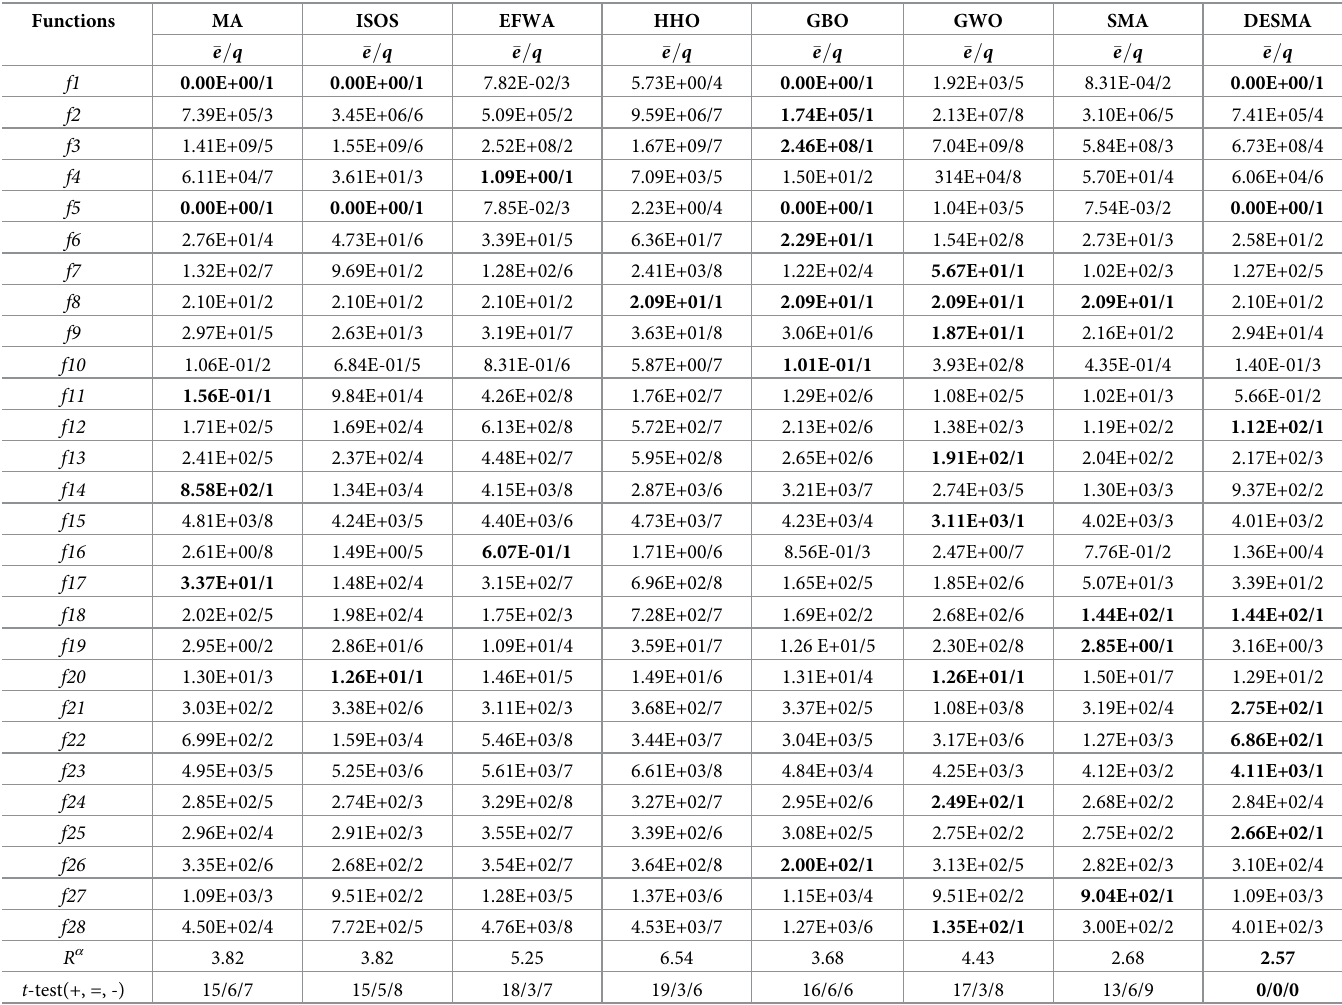
Table 3. Algorithm test